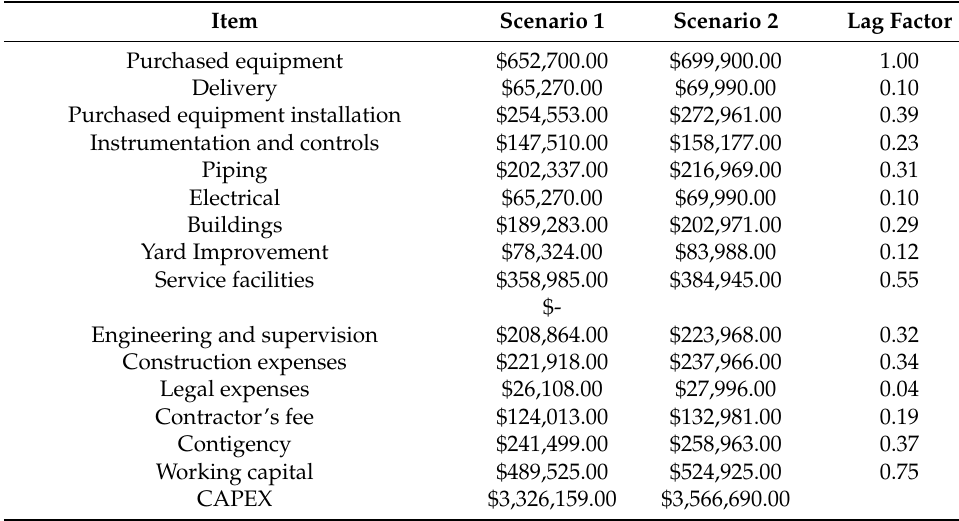
Table 5. Capital expenses for Scenario 1 and Scenario